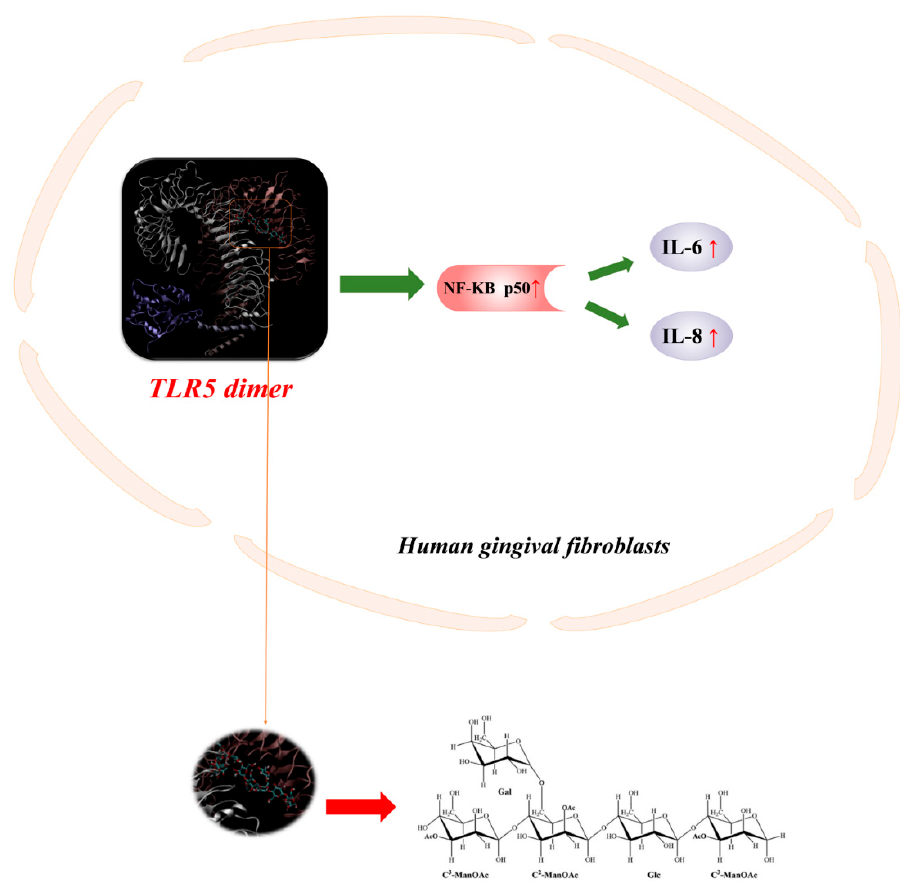
Figure 4. Acemannan induction of IL-6 / -8 expression and p50 / DNA binding in gingival fibroblasts via TLR5 / / NF- κ B-dependent signaling pathway.